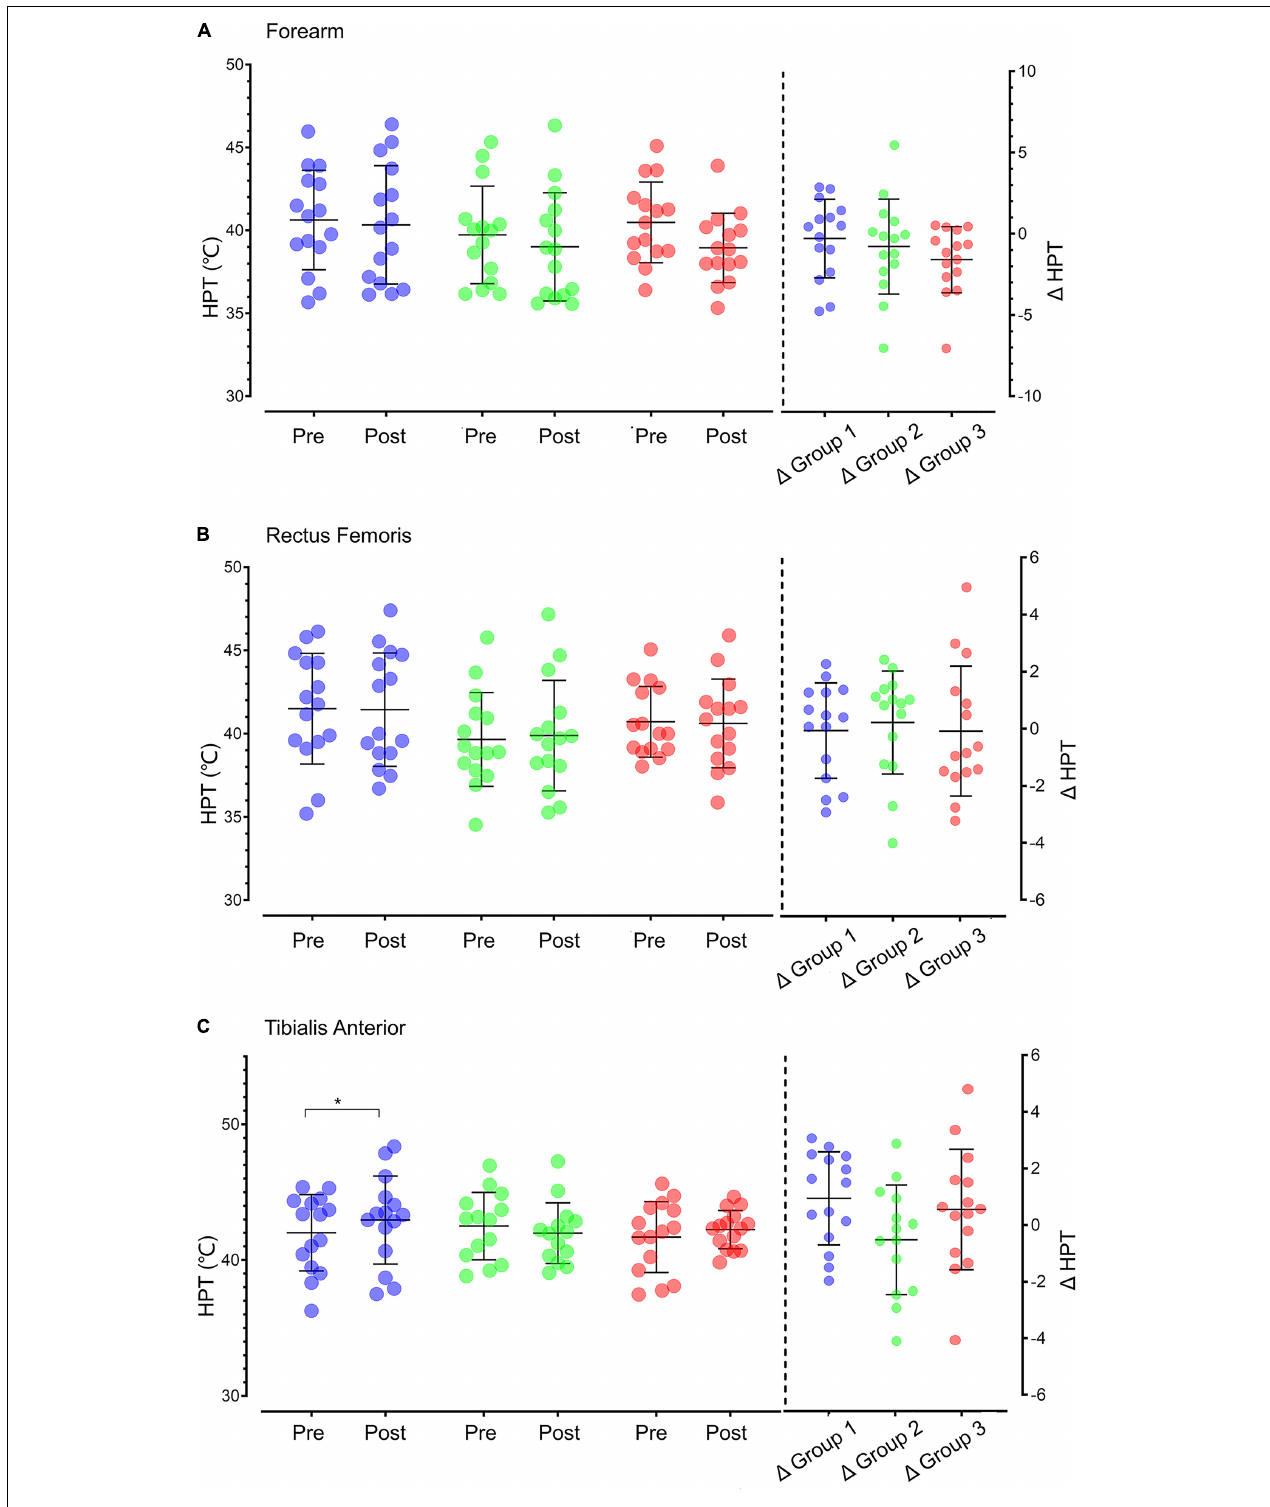
FIGURE 3 | HPT in different sites in the three groups before and after intervention. (A) Forearm HPT. (B) Rectus femoris HPT. (C) Tibialis anterior HPT. The data on the left side of the vertical dotted line are the HPT values of individuals (dots: purple for Group 1, green for Group 2, and red for Group 3) and groups (black line: X ± SD) before and after intervention. The data on the right side of the vertical dotted line are the values of the difference in HPT after intervention ( (cid:77) = posttest–pretest) for individuals (dot) and groups (black line: X ± SD). HPT, heat pain threshold; Pre, pretest; Post, posttest; * p < 0.05.